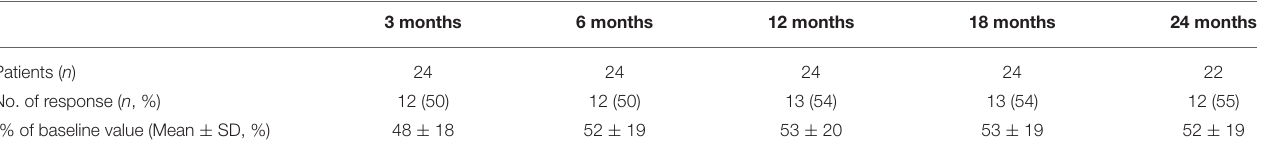
TABLE 3 | Response of AML volume to everolimus